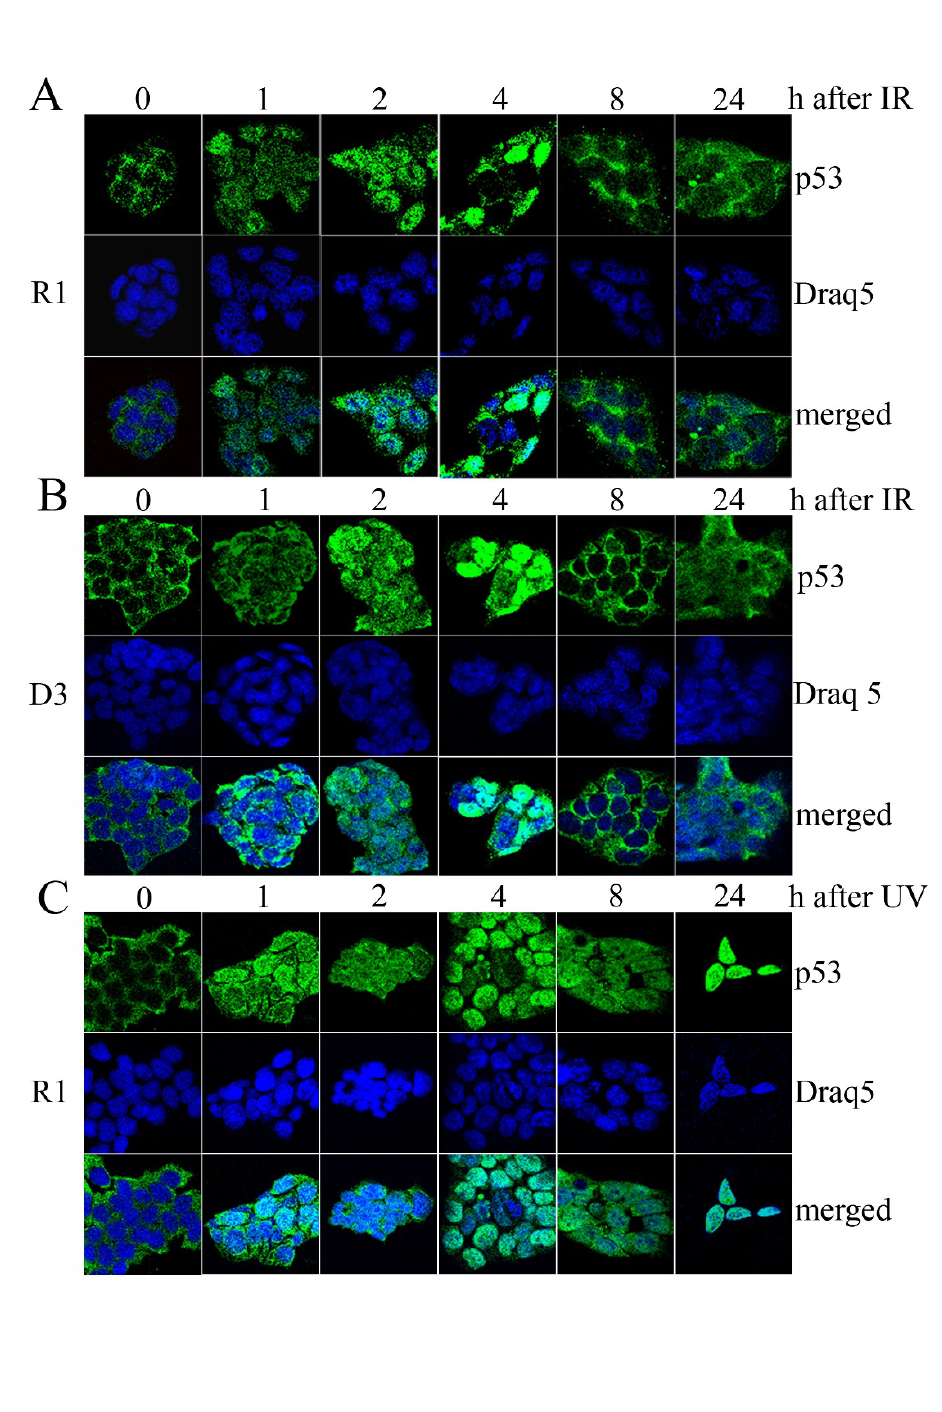
Figure 2 p53 accumulates in the nucleus of irradiated ES cells . R1 (A, C) and D3 (B) stem cells, grown on feeders, were irradi- ated two days after plating with 7.5 Gray IR (A, B) or with 30 J/m2 UVC light (C) and harvested at the indicated times. Cells were fixed in acetone/methanol, permeabilized with Triton-X-100 and incubated with the anti-p53 antibody Pab 421. After incubation, cover slips were washed and incubated with an antibody directed against mouse IgG, coupled to Alexa-Fluor-488 (green). To visualize the nuclei, cover slips were incubated with Draq5